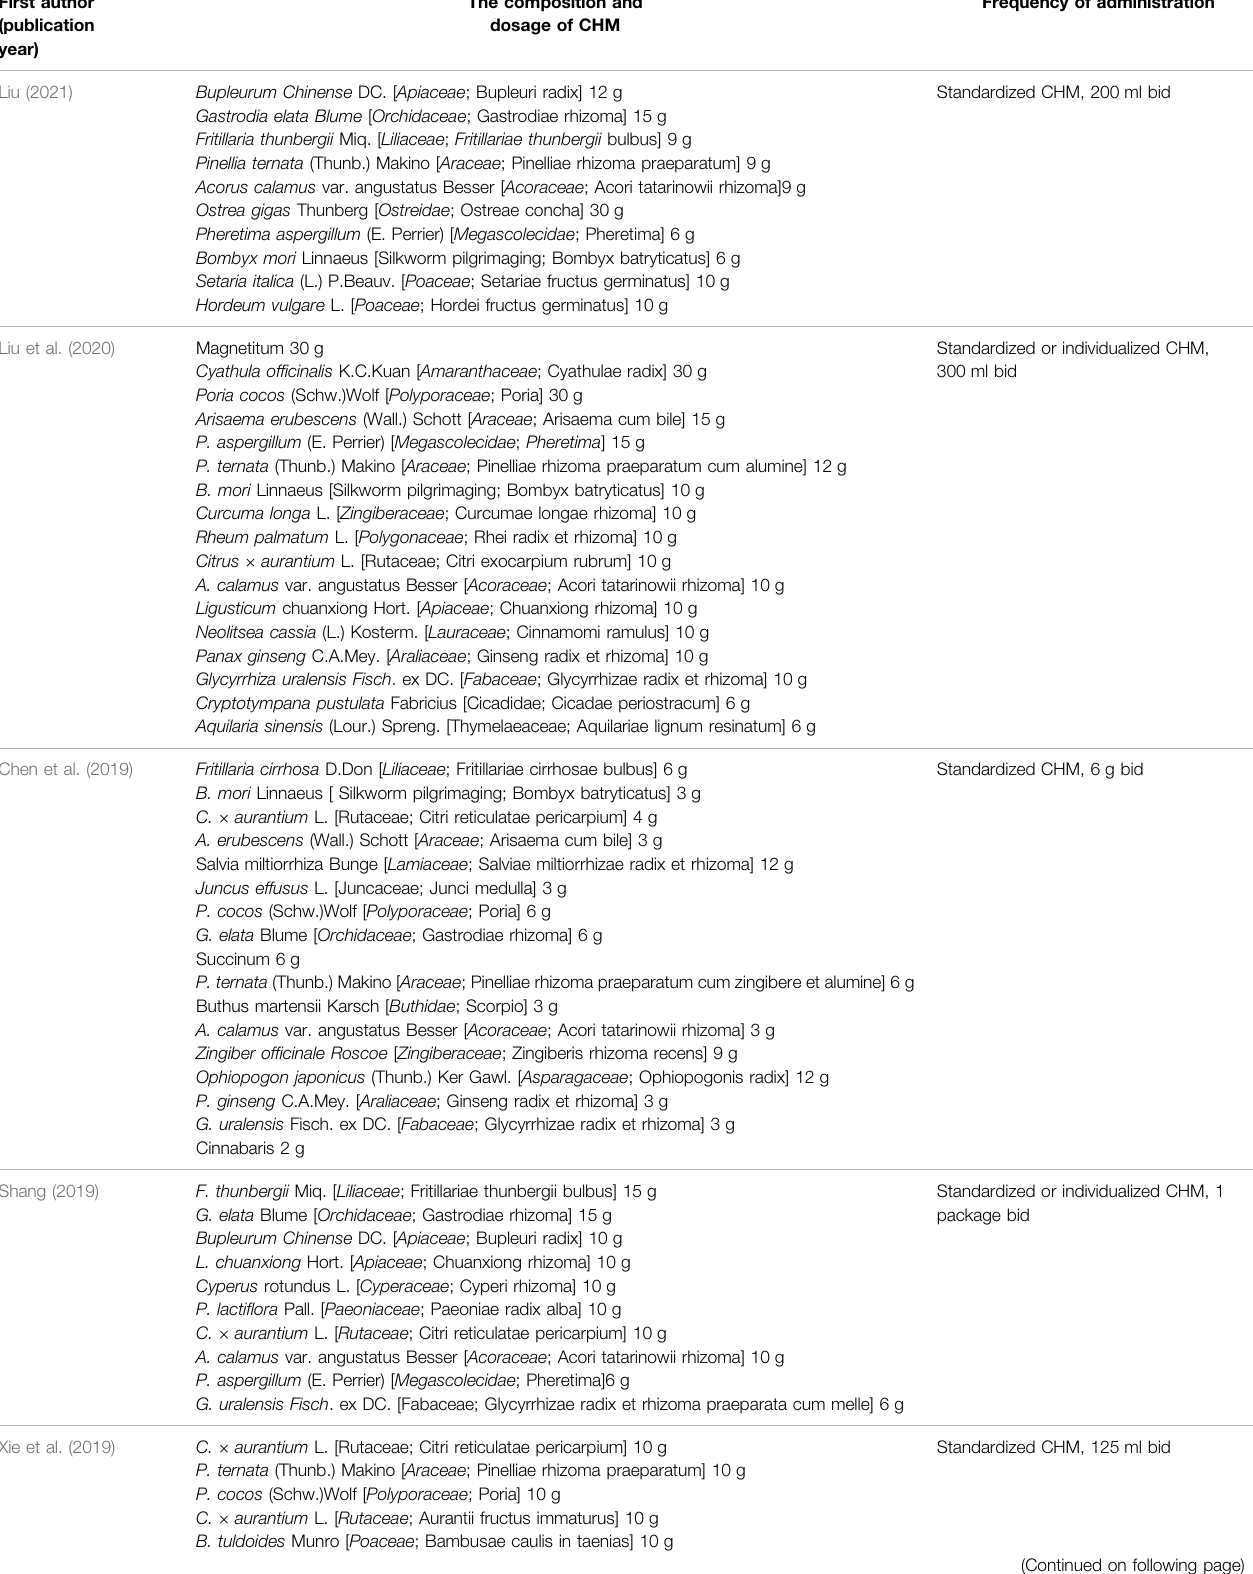
TABLE 2 | The composition and dosage of CHM reported in each